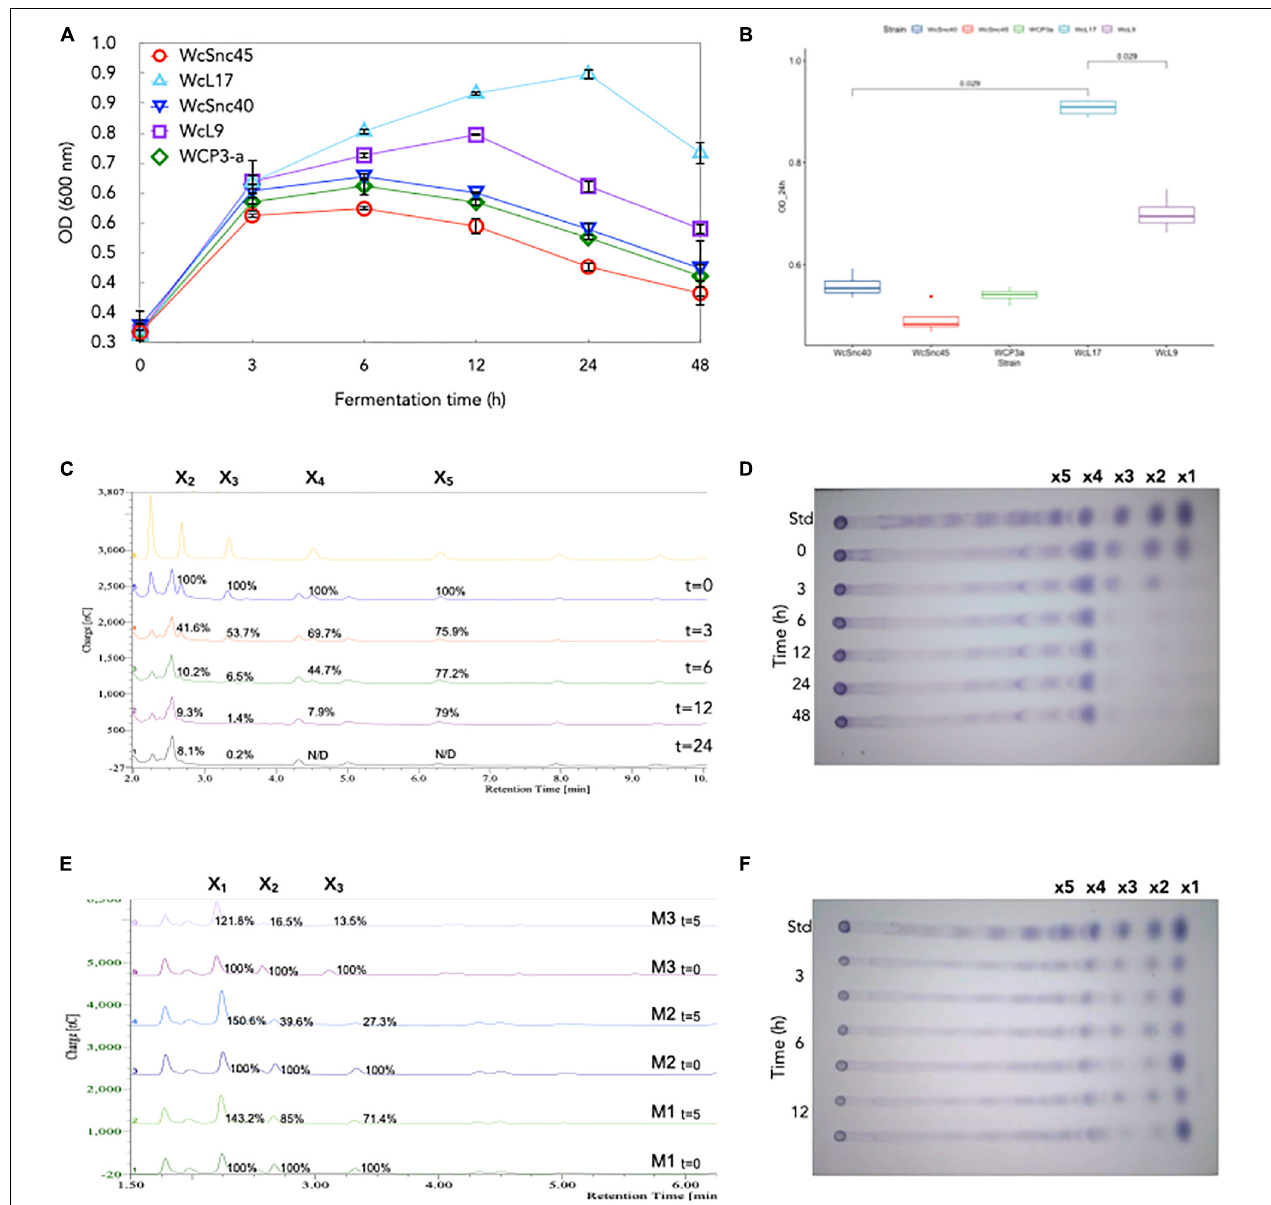
FIGURE 2 | Growth and profile of xylooligosaccharides (XOS) in cultures with five Weissella strains isolated from pozol . (A) Biomass accumulation (OD) during fermentation. (B) Biomass accumulation (OD) after 24 h of growth. Statistically significant differences ( p < 0.5) for strain WcL17 growth were obtained with the ggpubr package in R v4.0.2. XOS consumption during strain WcL17 culture was evaluated by (C) HPAEC-PAD chromatograms and (D) TLC plates. XOS hydrolysis by xylosidase activity in samples from WcL17 culture at M1 = 3 h, M2 = 6 h, and M3 = 12 h were also evaluated at baseline ( t = 0) and after 5 h ( t = 5) of reaction by (E) HPAEC-PAD chromatograms and (F) TLC